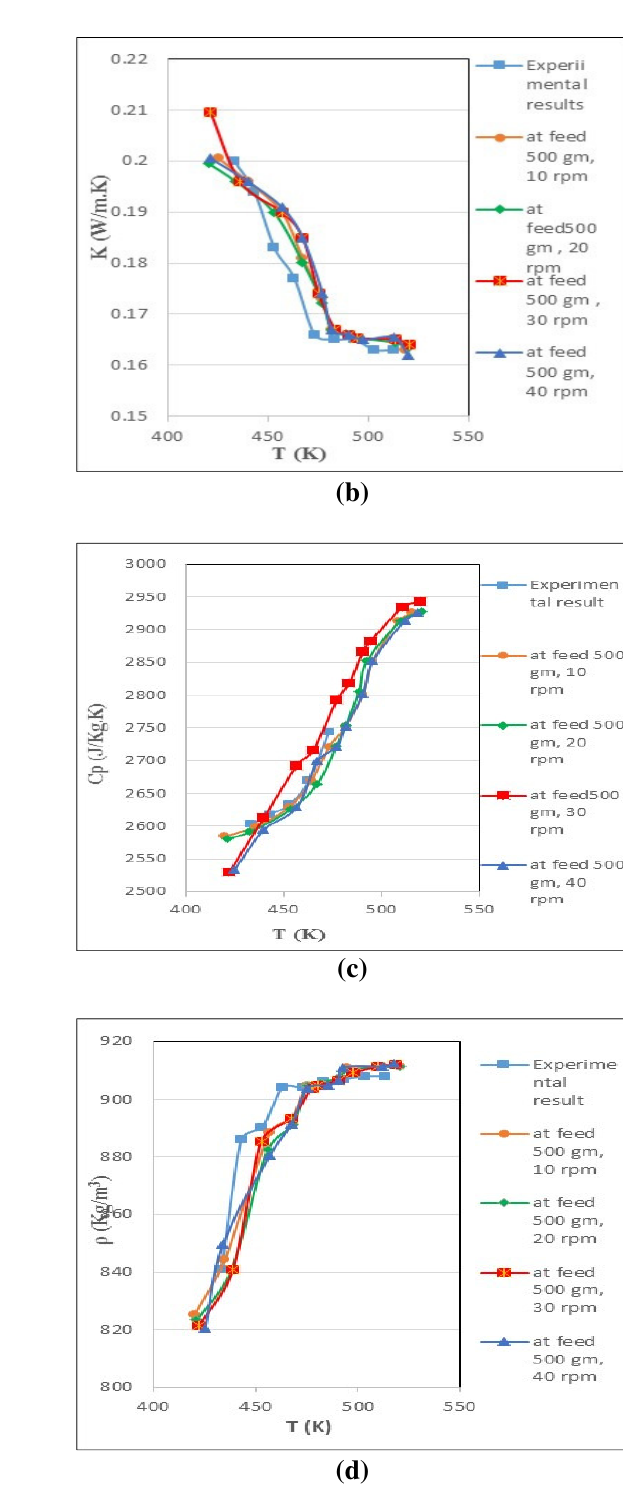
Fig. 14. Thermophysical properties of polypropylene 575 for experimental and simulation results at different temperature (a) Viscosity, (b) thermal conductivity, (c) Specific heat, (d) Density